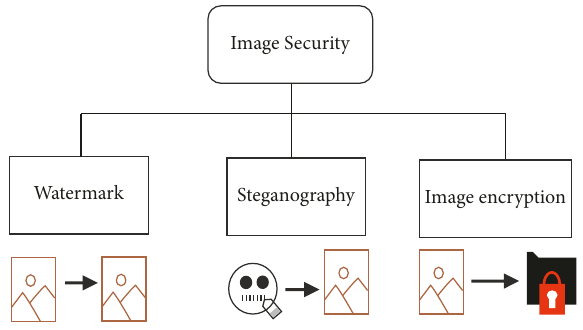
Figure 1: Type of image security as